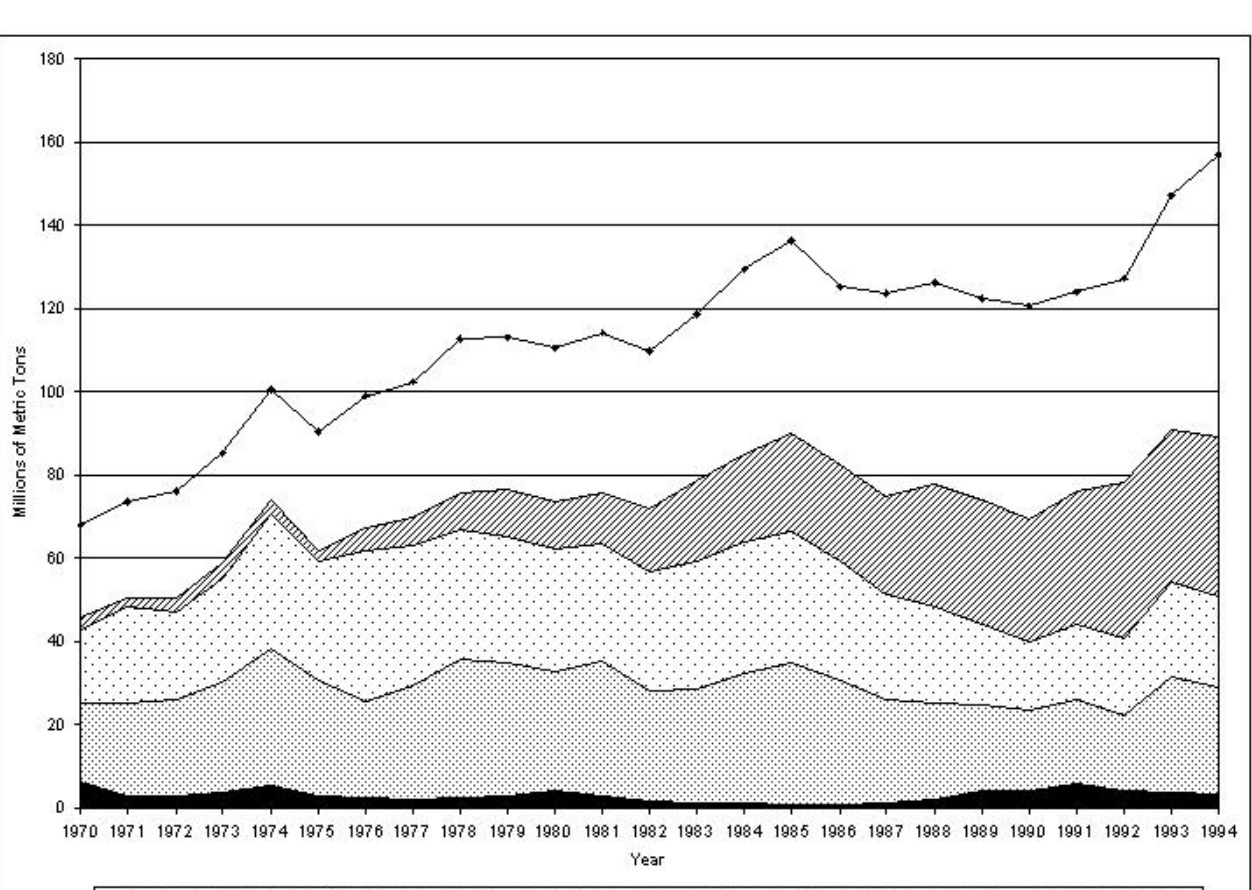
Fig. 2. World steel exports,